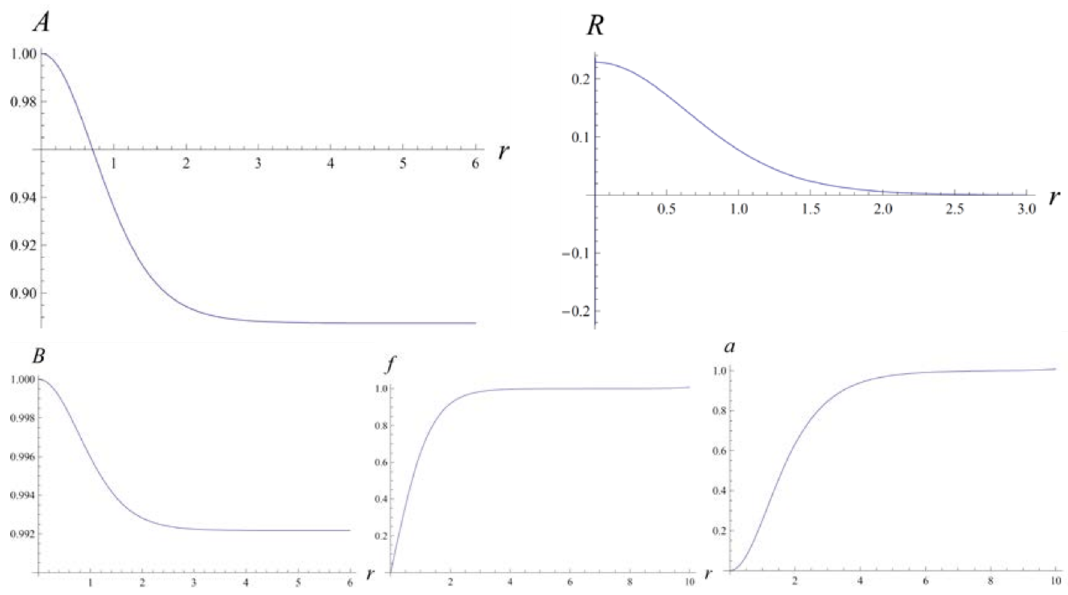
Figure 8 . Case α = 5 . The Ricci scalar at the origin and the angular deficit is basically five times less than in the α = 1 case. The mass is comparable to the other cases. Figure 9 . Case α = 10 . This is the case with the weakest gravitational coupling where the initial value of the Ricci scalar and the angular deficit are the smallest (basically 10 times smaller than in the α = 1 case). The mass is again comparable to the